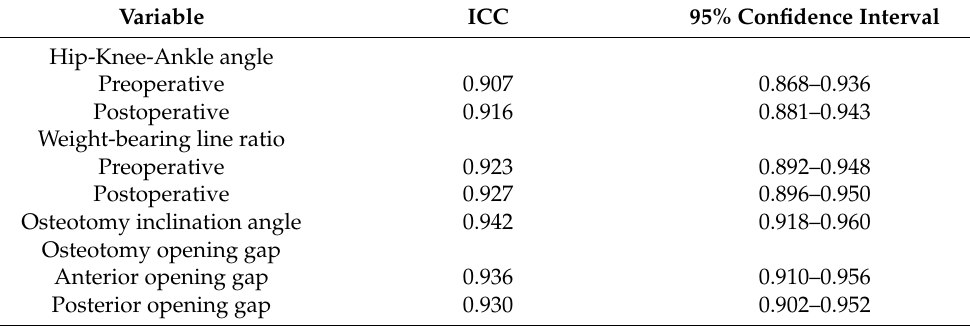
Table A1. Intraclass correlation